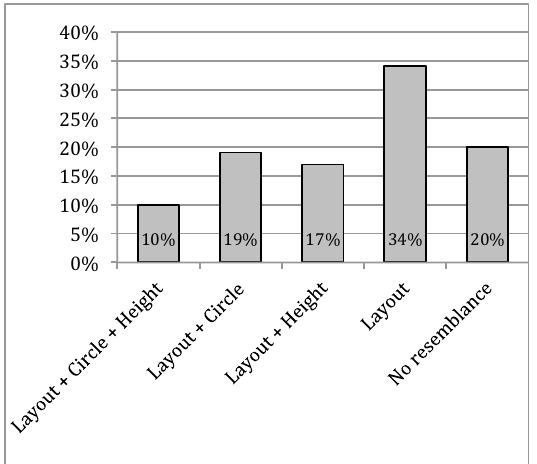
Figure 9. Percentage of sketches per category for Task4 (sketching